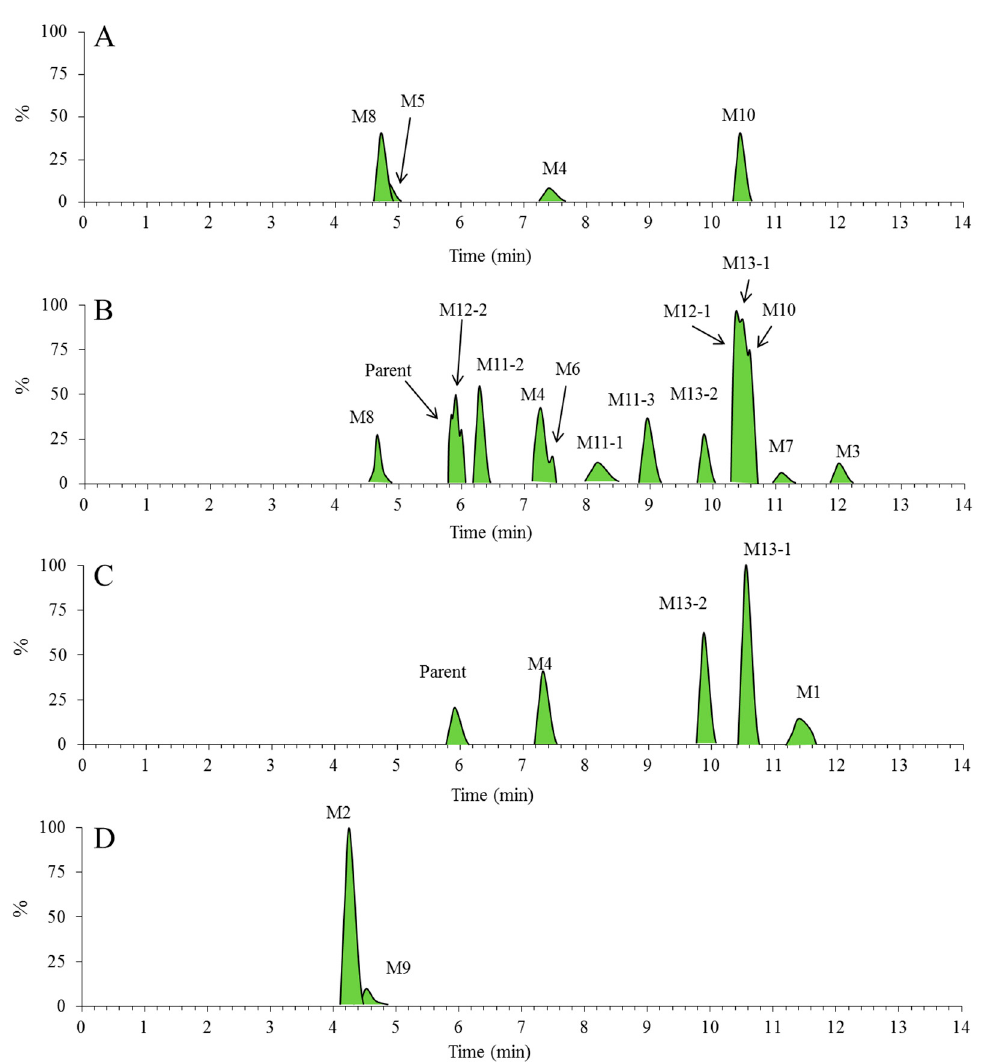
Figure 4. The extracted ion chromatograms for metabolic profile of Rg5. Numbers are labeled for each metabolite sample from RLMs, urine, feces and plasma (( A ) the RLMs of 1 h; ( B ) the feces of 0–24 h; ( C ) the plasma of 0–4 h; ( D ) the urine of 0–24 h).